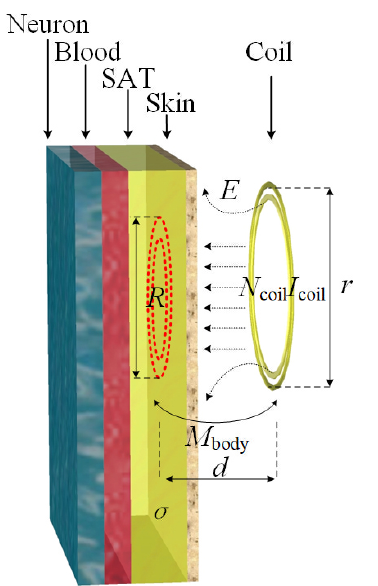
Figure 3. Diagram of relative position between human tissue and coupling coils.